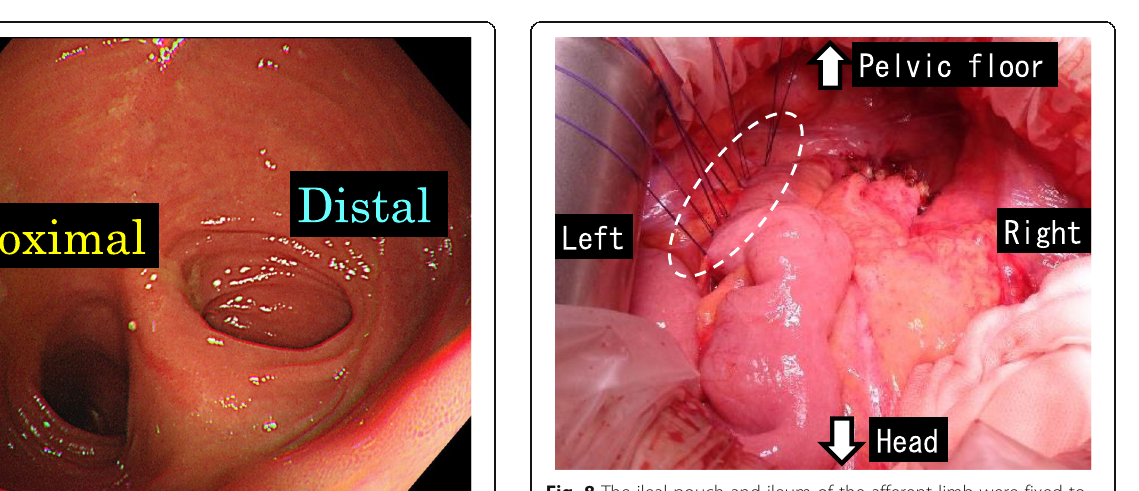
Fig. 8 The ileal pouch and ileum of the afferent limb were fixed to the left retroperitoneum by suturing (white dotted